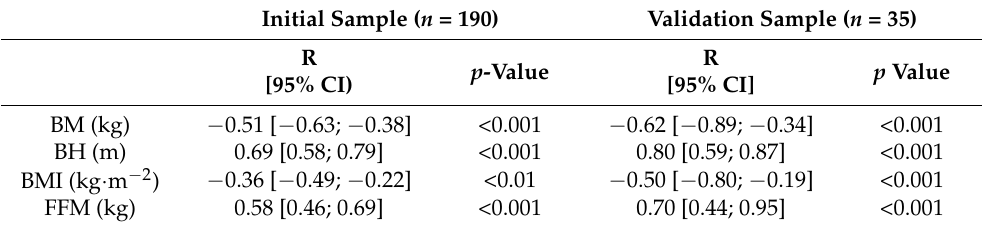
Table 2. Correlation between 6MWD and body size/shape in both initial sample and valida- tion